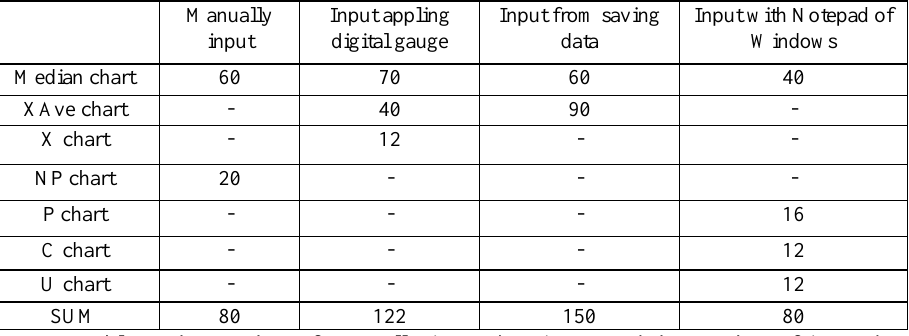
Table 3. Construction based on actual scenario for data input mode and type.